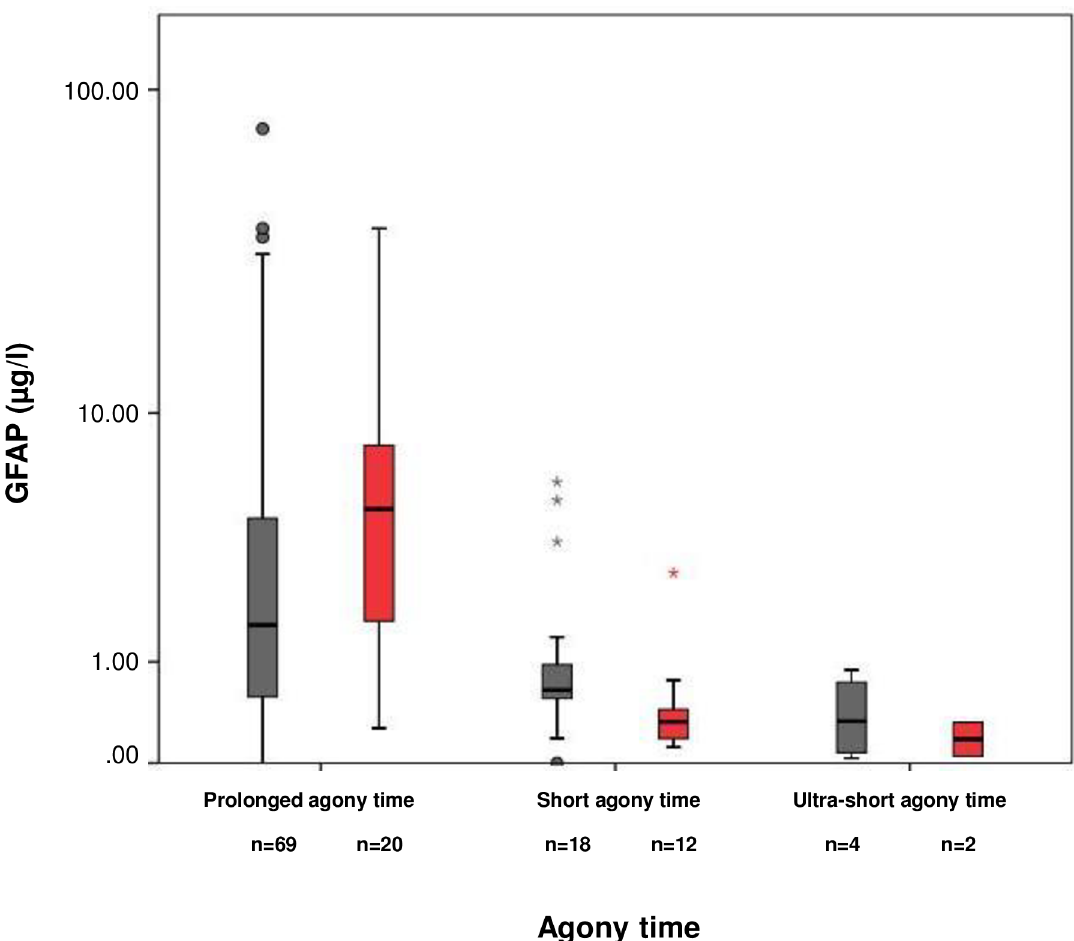
Fig 3. Post-mortem GFAP serum concentrations of the (cid:3) brain injury group. Post-mortem GFAP serum concentrations of the (cid:3) brain injury group (including all cases with a primary cerebral cause of death, all cases having macroscopic changes in brain integrity [such as cerebral edema and cerebral hemorrhage], and all cases in which the brain was exposed to hypoxia or ischemia [i.e., respiratory cause of death, exsanguination, multi-organ-failure, resuscitation]) and the control group (without brain injury) stratified according to agony time. GFAP concentrations of the brain injury group (grey bars): ultra-short agony times (median 0.35 μ g/l [IQR 0.76, minimum 0.03, maximum 0.83]; n = 4), short agony times (0.64 μ g/l [0.51, 0.10, 5.87]; n = 18), and prolonged agony times (1.58 μ g/l [3.91, 0.21, 76.25], n = 69; Kruskal Wallis p = 0,018; post-hoc ultra-short versus prolonged agony times p = 0.032, short versus prolonged agony times p = 0.041) GFAP concentrations of the control group (without brain injury; red bars): ultra-short agony times (median 0.19 μ g/l [IQR 0.27, minimum 0.05, maximum 0.32]; n = 2, p = 0.643), short agony times (0.33 μ g/l [0.30, 0.12, 2.68]; n = 12), and prolonged agony times (4.71μg/l [7.33, 0.27, 38.00], n = 20; Kruskal Wallis p < 0.001; post-hoc ultra-short versus prolonged agony times p = 0.040, short versus prolonged agony times p <